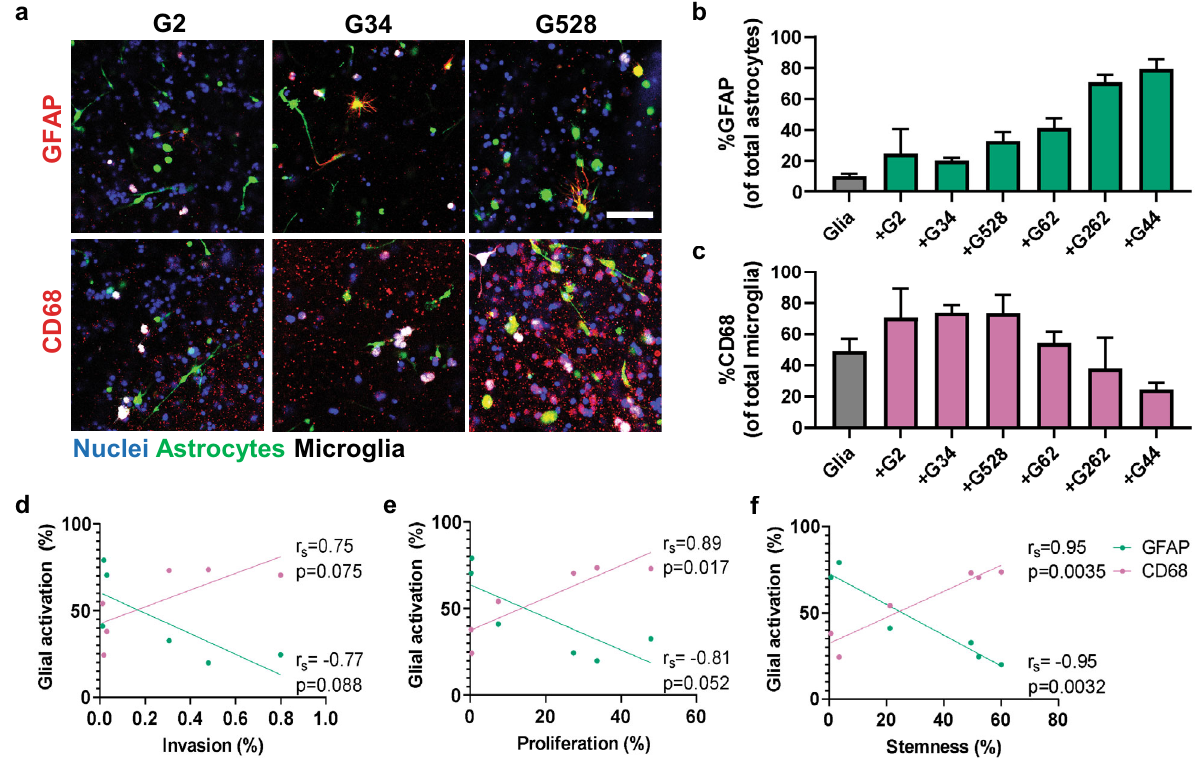
Fig. 5 Glial reactivity to glioma cells is patient-dependent, and astrocyte reactivity correlates with glioma CD71 expression. a Representative immuno fl uorescence images showing expression of reactivity markers GFAP (red, astrocytes) or CD68 (red, microglia) for glial cells alone (AM) or in tri-culture with G2, G34, and G528. Glioma cells (blue) are labeled only with DAPI, while CellTrackers label the astrocytes (green) and microglia (white). Some G528 cells also labeled with CD68. Scale bar is 100µm. b Quanti fi ed number of GFAP + astrocytes as a percent of total astrocytes. c Quanti fi ed number of CD68 + microglia as a percent of total microglia. d Correlation plot of GFAP and CD68 expression vs. GSC invasion data. e Correlation plot of GFAP and CD68 expression vs. GSC Ki67 expression data. f Correlation plot of GFAP and CD68 expression vs. GSC CD71 expression data. Spearman correlation coef fi cients and p values are shown in respective plots, with n = 3 trials per cell